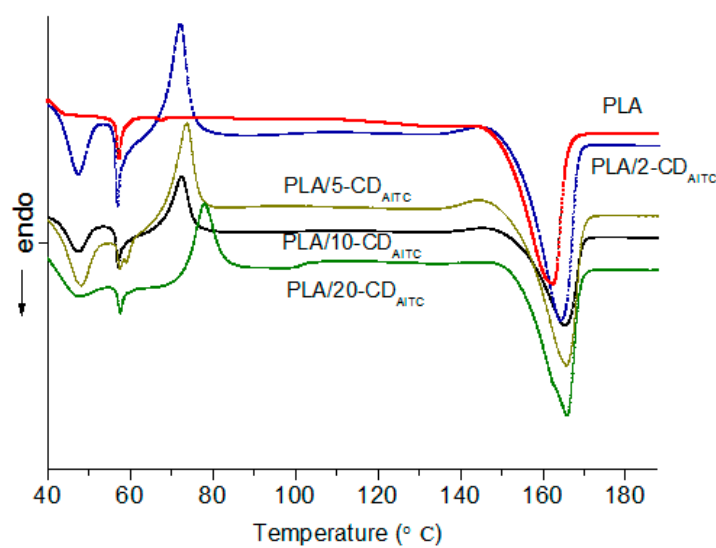
Figure 1. Differential Scanning Calorimetry (DSC) thermograms of the PLA film with different amounts of β -CD/AITC. PLA/2-CD AITC , PLA/5-CD AITC , PLA/10-CD AITC , PLA/20-CD AITC : PLA films with 2%, 5%, 10%, 20% β -CD/AITC, respectively.